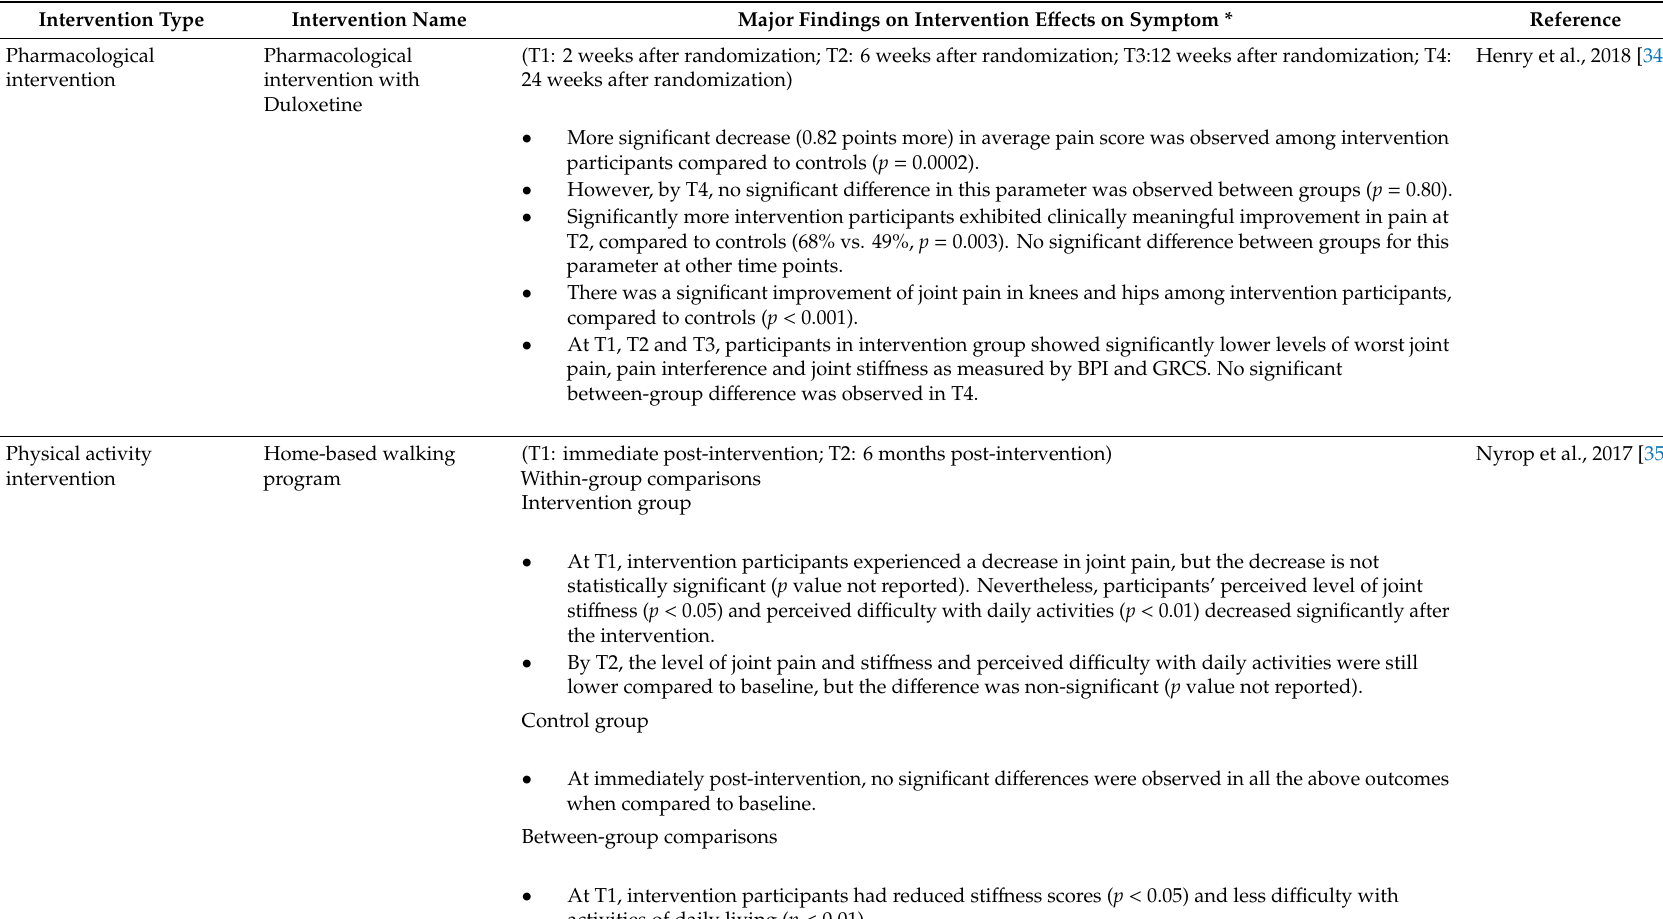
Table 5. A summary of the e ff ects of reported interventions on various endocrine therapy-induced joint